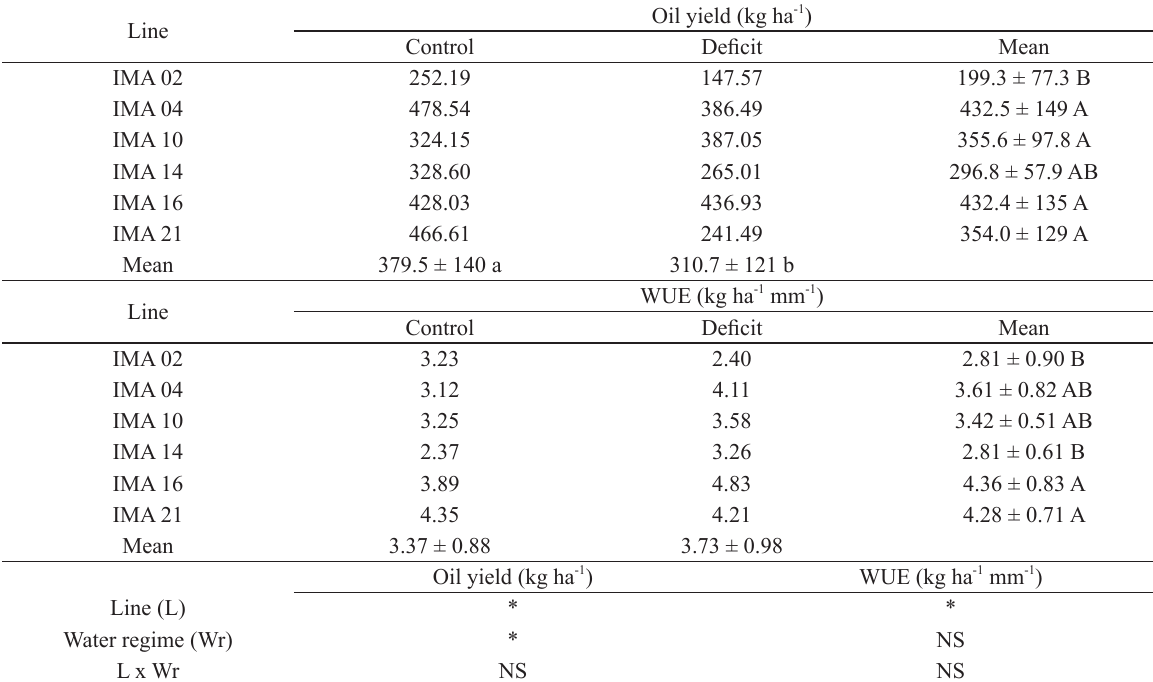
Effect of water deficit and rehydration on oil yield and water use efficiency (WUE) of six safflower lines